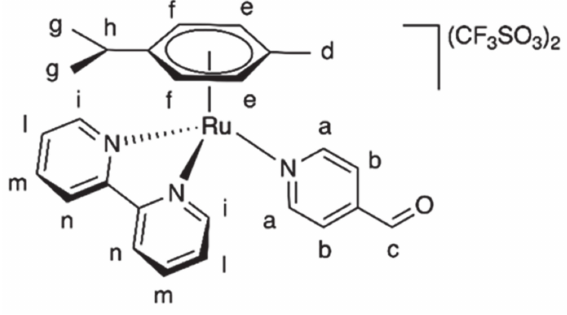
Figure 10. [( η 6 -p-cym)Ru(N,N (cid:48) -bpy)(4-formylpyridine)]( CF 3 SO 3 ) 2 (IC2). 3.1.6. [( η 6-p-cym)Ru(N,N (cid:48) -bpy)Cl](PF 6 ) (IC3) [( η 6 -p-Cym)RuCl 2 ] 2 (0.150 g, 0.25 mmol, 1 eq.), 2,2 (cid:48) -bipyridine (0.076 g, 0.49 mmol, 2 eq.) and KPF 6 (0.090 g, 0.49 mmol, 2 eq.) were dissolved in dry methanol in a